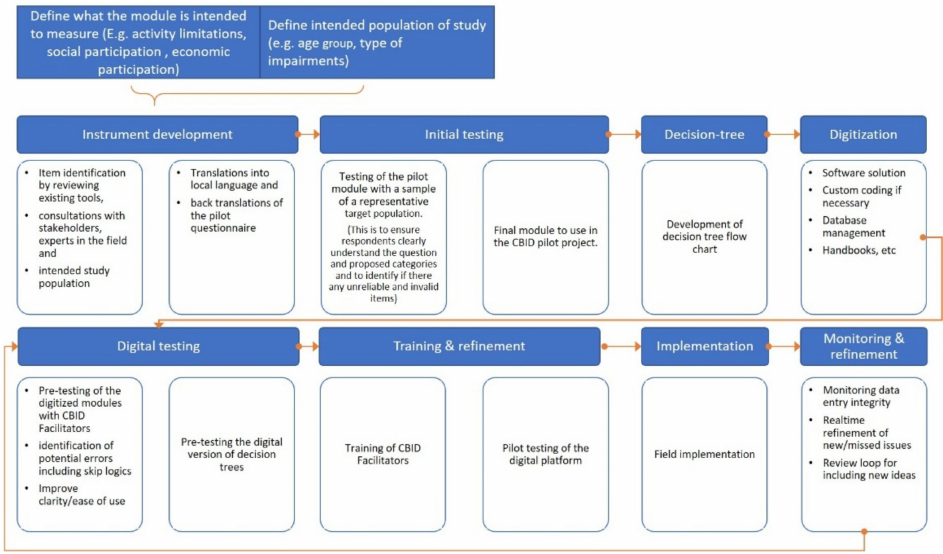
Figure 1. Development process for the modular